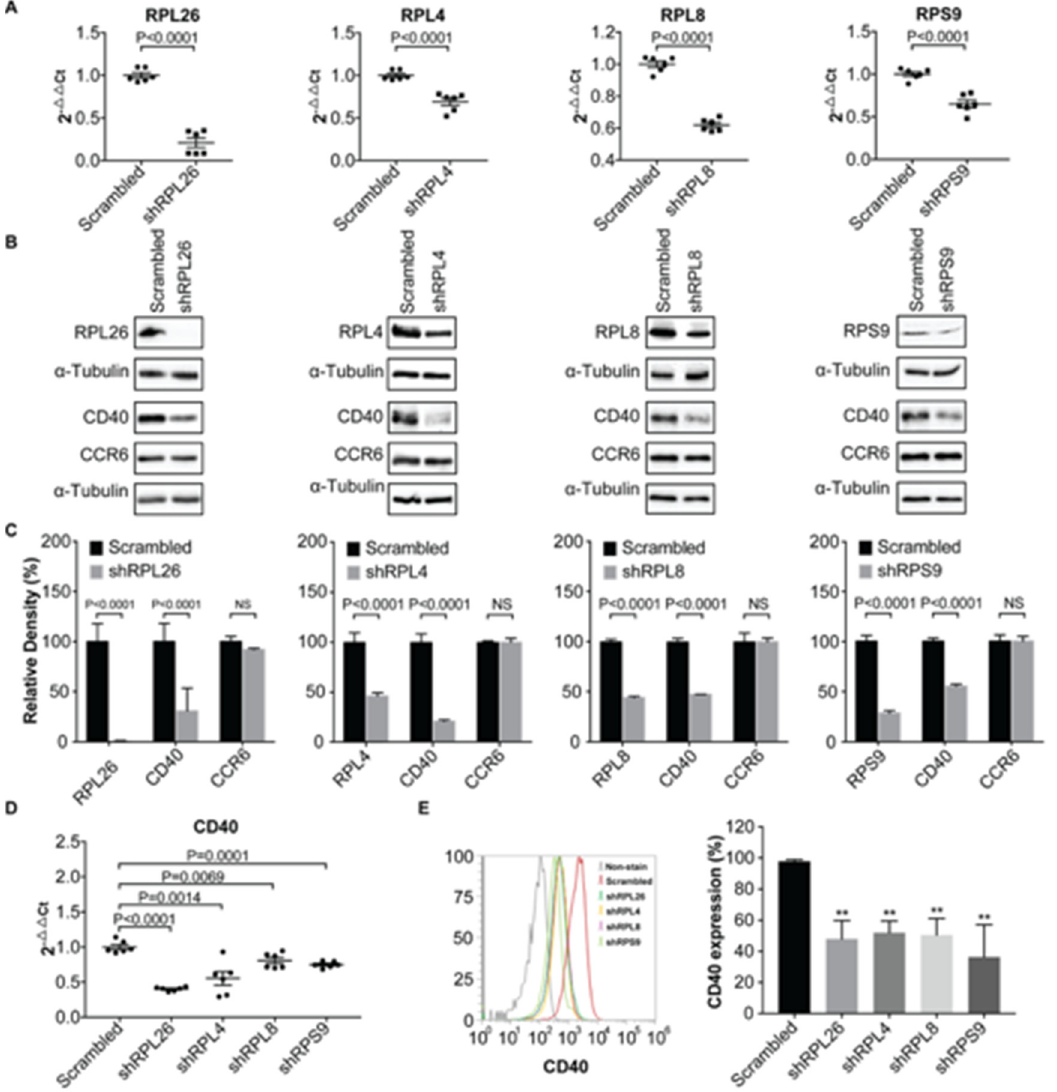
Figure 1. Demonstration of RPL26, RPL4, RPL8, and RPS9 , as CD40 transcription regulators in human B cells. ( A ) Knockdown of RPL26, RPL4, RPL8 , and RPS9 , in human BL2 cells using shRNA as shown by real time PCR. ( B ) Western blots showing downregulation of RPL26, RPL4, RPL8, and RPS9 results in decreased expression of CD40 , but not CCR6 in BL2 cells. Whole cell protein was used for Western blots. ( C ) Statistical analysis of Western blots in ( B ) based on relative density. NS: not significant. ( D ) Down-regulation of CD40 expression on mRNA levels in the knockdown cells, suggesting a transcriptional regulation of CD40 expression. α -Tubulin was used for loading control. CCR6 was used as a negative control for translational regulation. ( E ) FACS analysis of CD4 0 surface expression in the RPL26, RPL4, RPL8, and RPS9 shRNA knockdown BL2 cells. Scrambled: scrambled shRNA control. sh: shRNA. **: p value < 0.01.